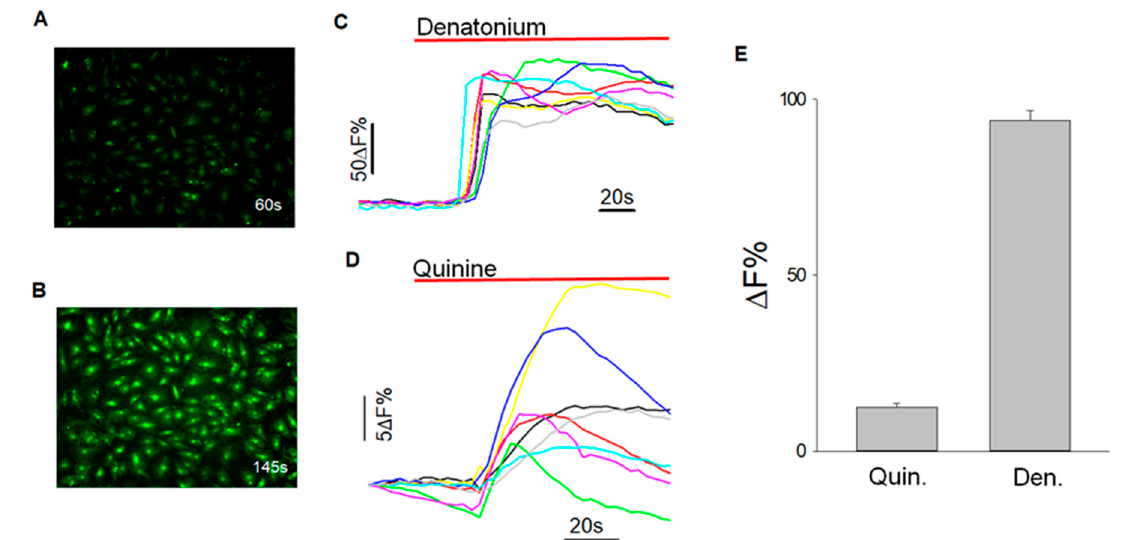
Figure 6. Calcium imaging to quantify tastant-evoked changes in intracellular calcium level. ( A ) BTBC before exposure to denatonium (2 mM) at 60 secs; ( B ) cells with change in fluorescence intensity after exposure to denatonium (2 mM) at 145 secs; ( C ) graph corresponding to response data of selected cells after exposure to denatonium benzoate (2 mM) after background subtraction; ( D ) graph corresponding to response data of selected cells after exposure to quinine HCl (462.30 μ M); and ( E ) data are represented as mean (+/ − SEM) of an increase in fluorescence (%) from baseline of three independent experiments. Denatonium-induced changes in relative fluorescence (%) was 93.97 +/ − 2.9 (data obtained from 187 cells of 3 experiments) and for quinine was 12.49 +/ − 1.11% (data obtained from 44 cells of 3 experiments).